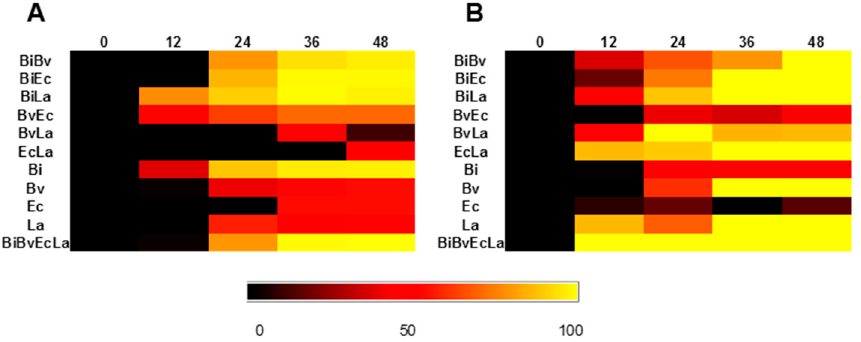
Figure 5. Consumption of 2FL ( A ) or FOS ( B ) in mono or co-culture. Values were calculated using the phenol-sulphuric method and expressed as percentage consumption relative to initial concentration.